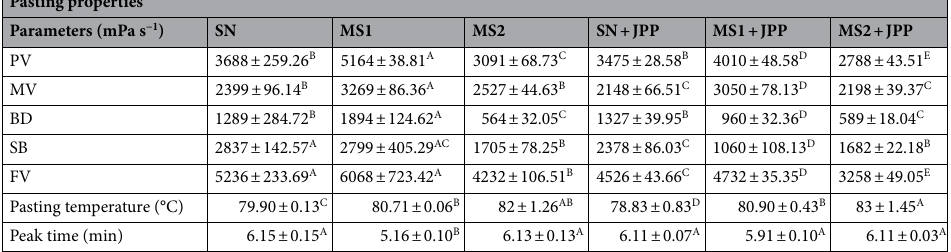
Table 2. Pasting properties of native red rice starch paste (SN), modified (MS1 and MS2) and their mixtures prepared with jaboticaba peel powder. PV Peak viscosity, MV Minimum viscosity, BD Breakdown, SB Setback, FV final viscosity. Different capital letters indicate a significant difference ( p < 0.05) between formulations for each parameter analyzed SN native starch, MS1 Modified starch by α-amylase, MS2 Modified starch by α-amylase and amyloglucosidase, JPP Jaboticaba peel